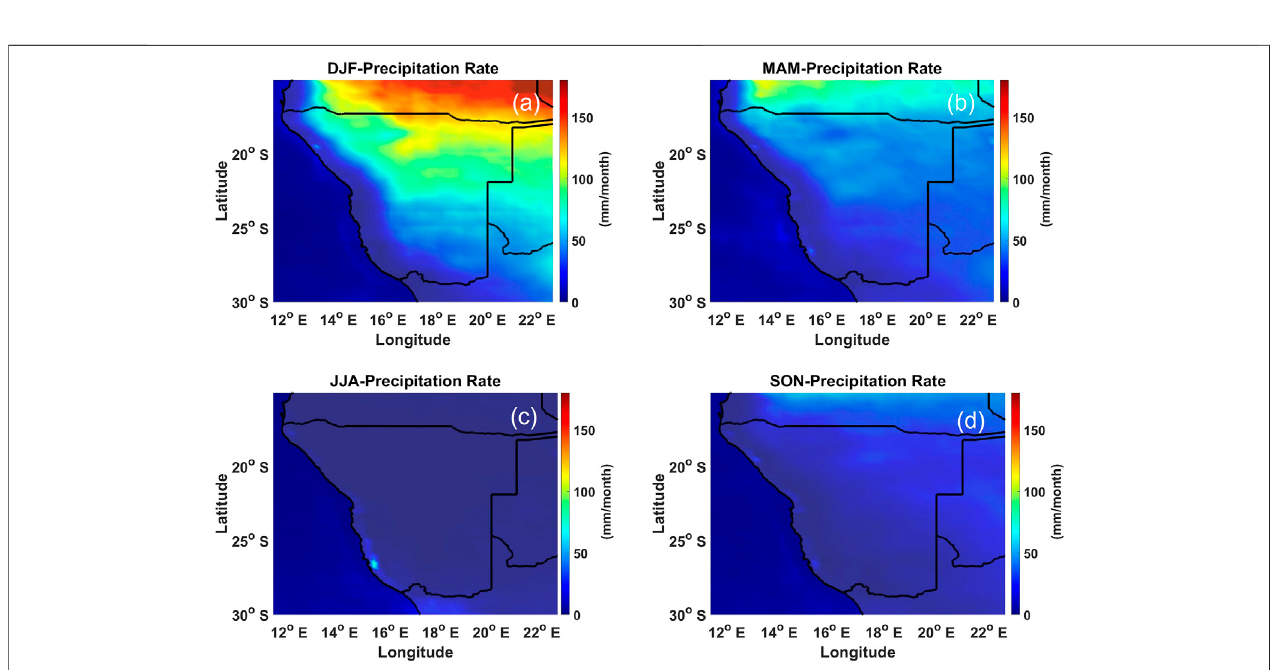
FIGURE 5 | Seasonal averaged precipitation rate from 1998 to 2020 in (A) DJF, (B) MAM, (C) JJA and (D) SON, obtained from TRMM.